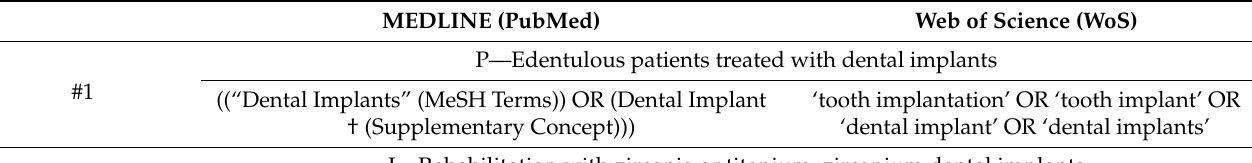
Table 1. Search strategy carried out and filters